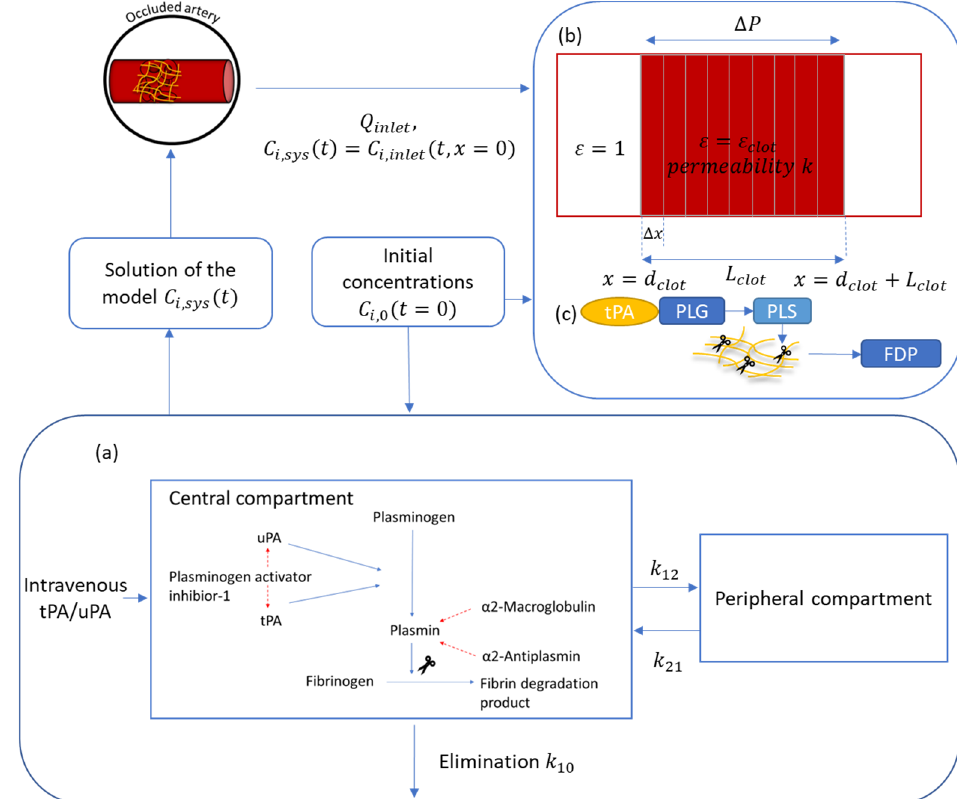
Figure 1. Overview of the 1D thrombolytic model. ( a ) Two-compartment PK-PD model. ( b ) Schematic of local PD model which couples 1D blood flow (in x -direction) with species transport and fibrinolytic reactions. The model solves clot lysis in an occluded artery where the red area indicates the clot with a porosity of ε clot and the open area is clot-free with ε = 1. ( c ) Fibrinolysis mechanism on fibrin.